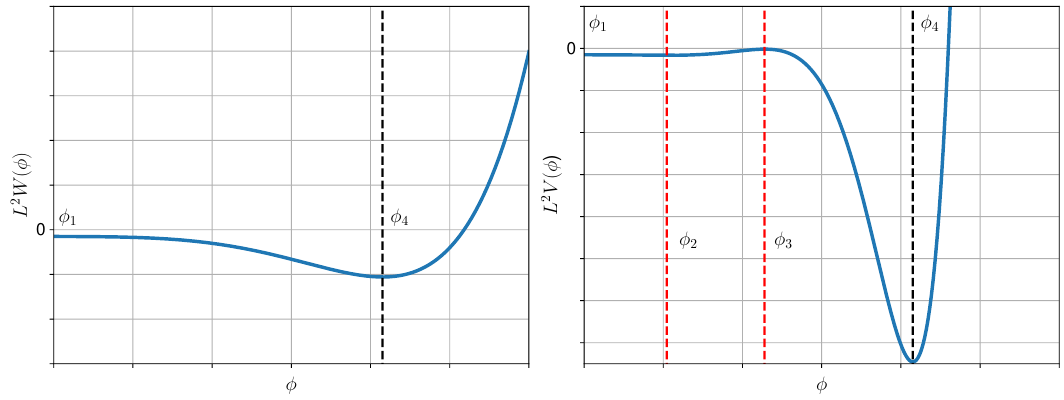
Figure 2 . Graphs of the superpotential W ( φ ) and potential V ( φ ) of the theory, with interesting points shown. The superpotential and potential share the BPS extrema φ 1 and φ 4 , whilst only the potential has the non-BPS extrema φ 2 and φ 3 . In this plot the values used are φ M = 0 . 5 and φ Q = 5 . 0